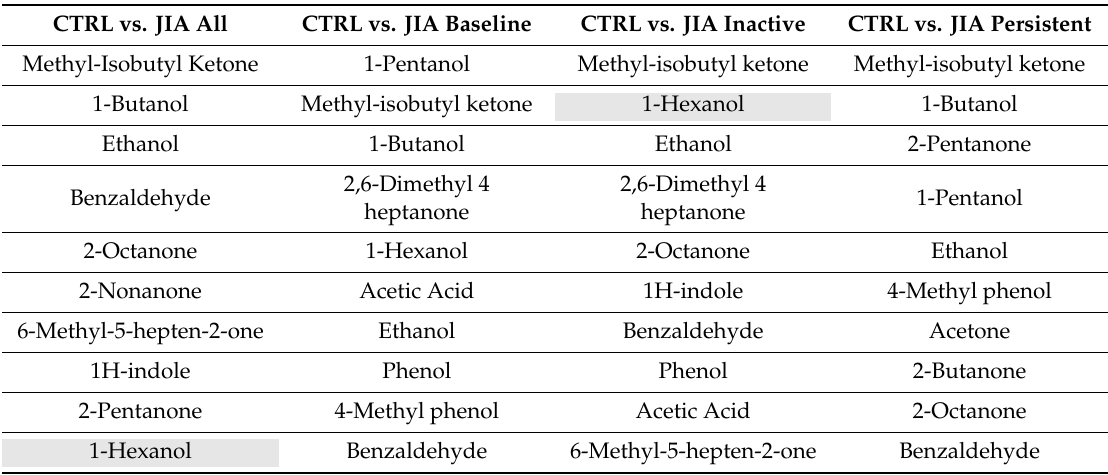
Table 3. Metabolites derived from PLSA-DA models in DCV of VOCs data matrix. CTRL vs. JIA All